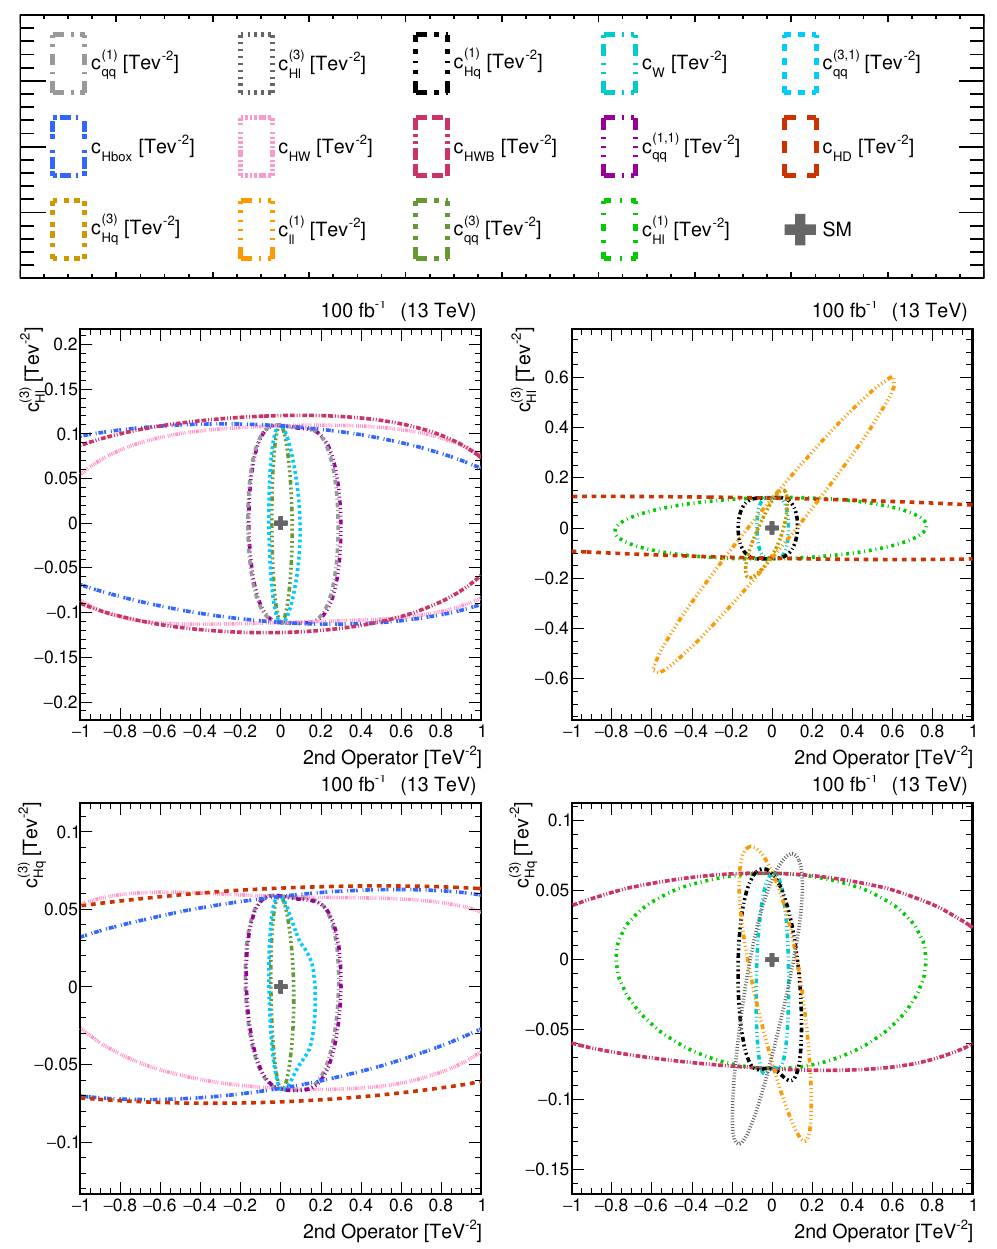
Figure 9 . Bi-dimensional likelihood contours for − 2∆ log L = 2 . 3 for the combination of diboson and leptonic VBS channels, for all coefficient pairs involving c (3) W ± Z + 2 j , ZZ + 2 j channels include the respective QCD-induced processes. Only two Wilson coefficients are varied at a time, while the others are fixed to zero. Quadratic EFT contributions are included in all cases. In each panel, the operator on the y axis is fixed, while the one on the x axis is different for each curve (see